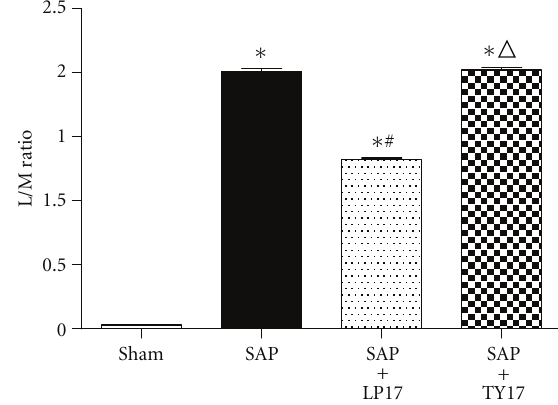
Figure 5: Intestinal permeability, as assessed by the lactu- lose/mannitol (L/M) excretion ratio.